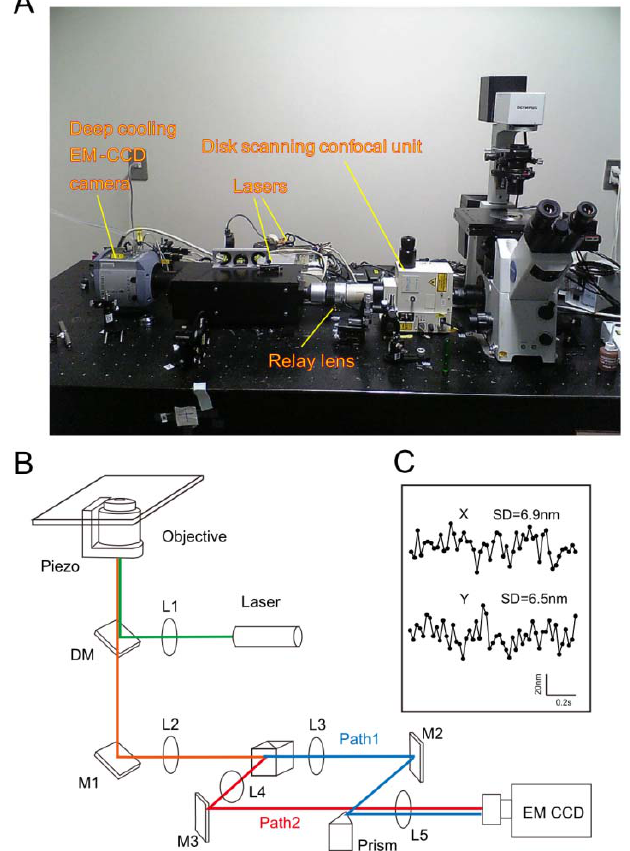
Figure 1. Optical system for single molecular imaging. ( A ) Photograph; ( B ) Schematic drawing of an optical setup for double imaging. A piezo actuator bound to the objective. L, lens; M, mirror; DM, dichroic mirror; HM, half mirror cube. Fluorescent images at two different wavelengths of QD (path 1 and path 2); ( C ) spatial precision of TatP-QDs in HeLa. Immobile TatP-QDs were tracked in HeLa. The S.D. of the position of QDs was 6.9 nm in the x axis and 6.5 nm in the y